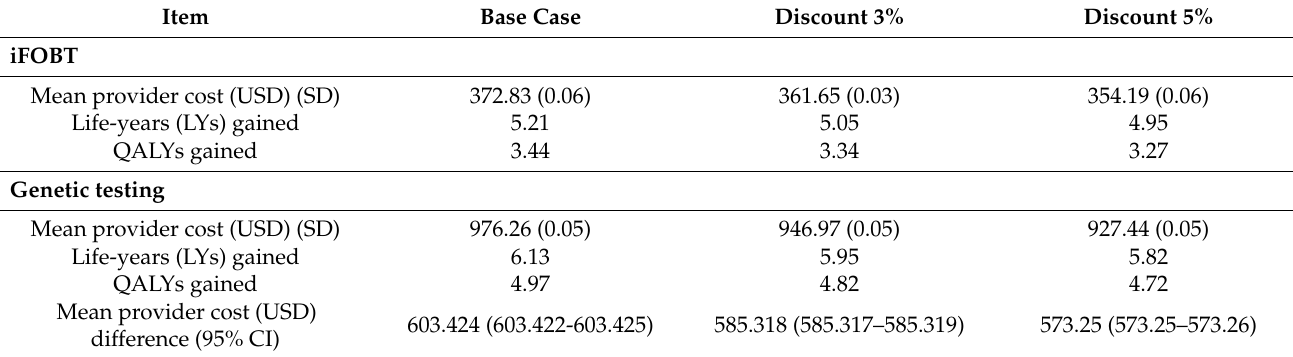
Table 8. Sensitivity analysis for the cost-effectiveness of genetic testing versus